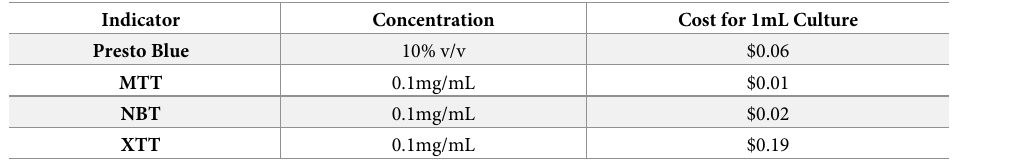
Cost comparison of PrestoBlue, MTT, NBT, and XTT based on listed working concentrations and prices from ThermoFischer